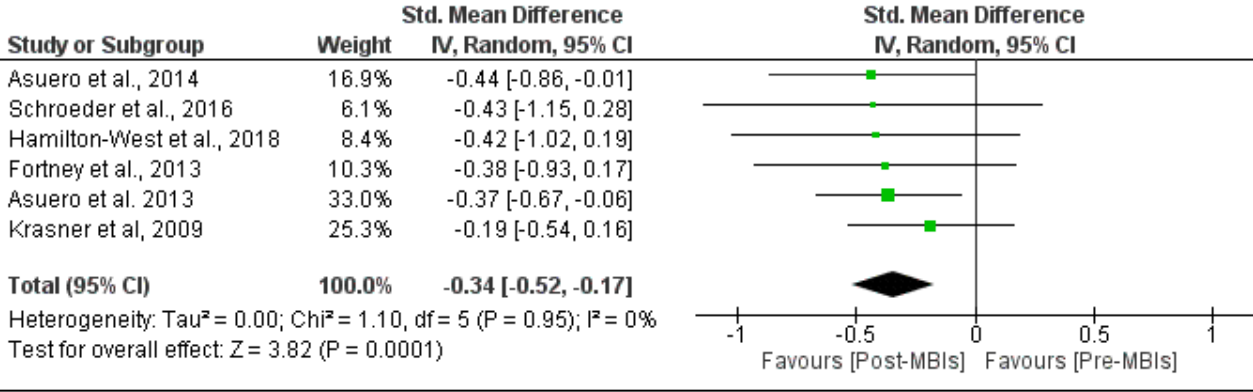
Figure 3. Effect of mindfulness-based interventions (MBIs) on depersonalization in primary healthcare professionals. Results are reported as standardized mean difference and 95% confidence interval (CI).